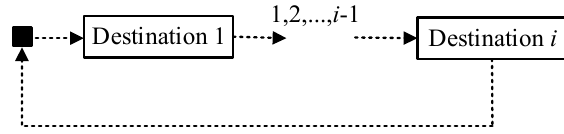
Figure 2. The schematic diagram of a closed-loop trip chain.